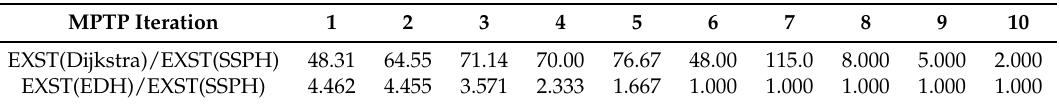
Table 8. Ratio between explored states for Dijkstra vs. A* with SSPH and A* with EDH vs. A* with SSPH , if the aircraft can only turn right.